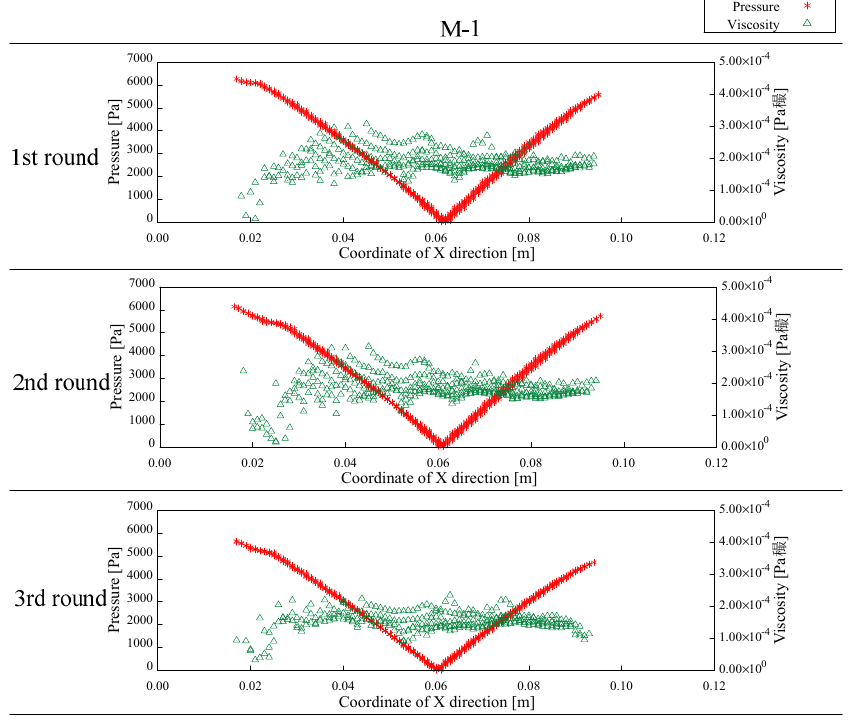
Figure 21. Comparison of the values of the pressure and viscosity coefficient from the simulation results of M-1.